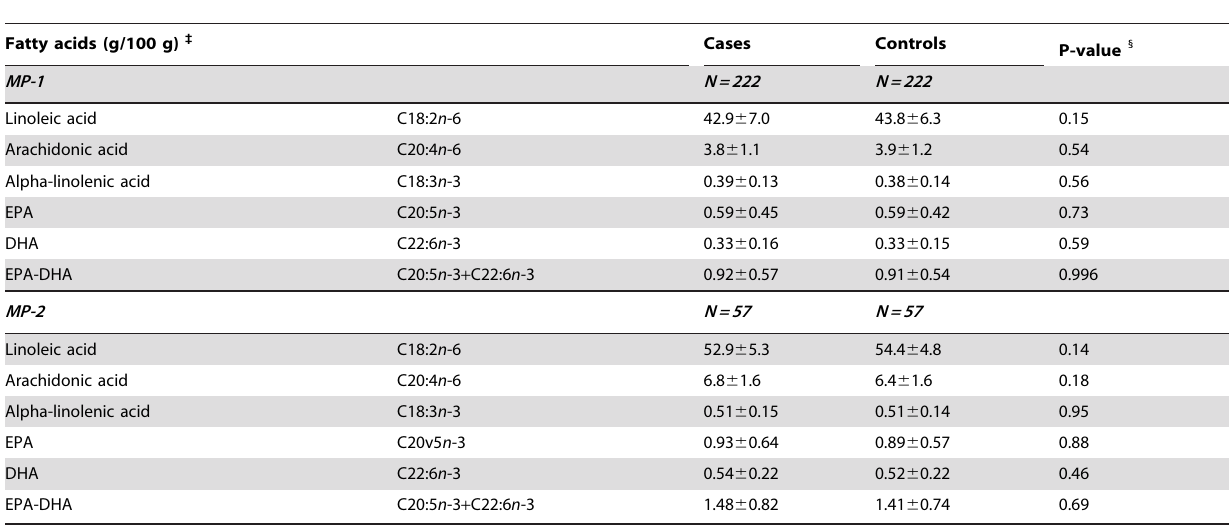
Table 2. Fatty acid proportions in plasma cholesteryl esters in 279 Dutch fatal CHD cases and 279 matched controls. *, {